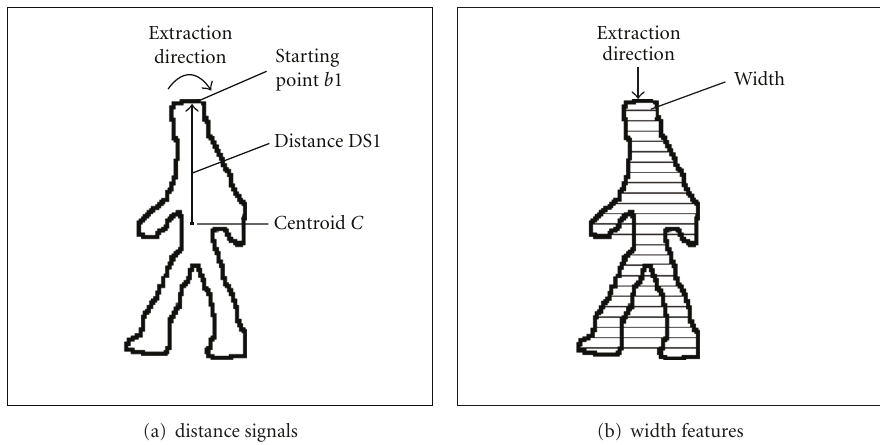
Figure 3: The illustration of feature